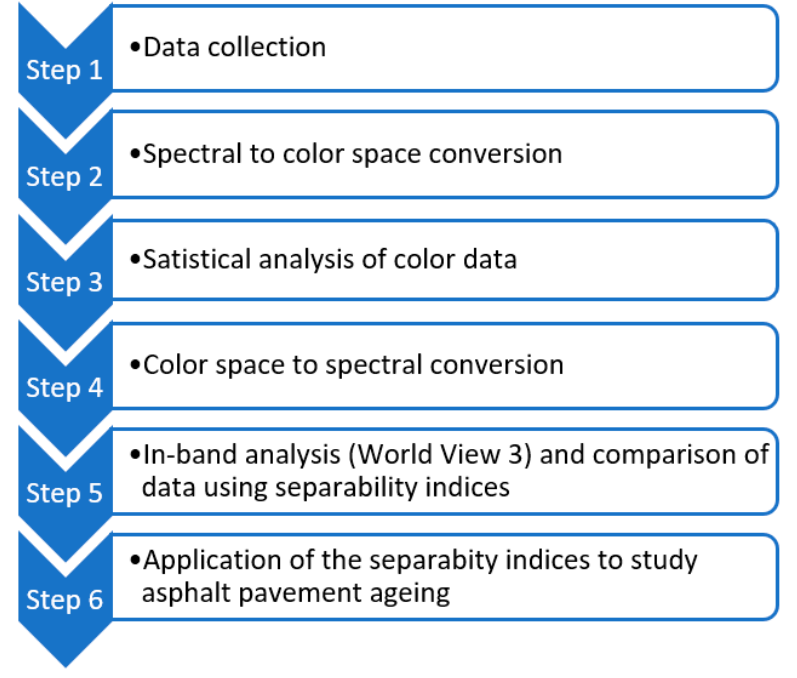
Figure 1. Overall Methodology.